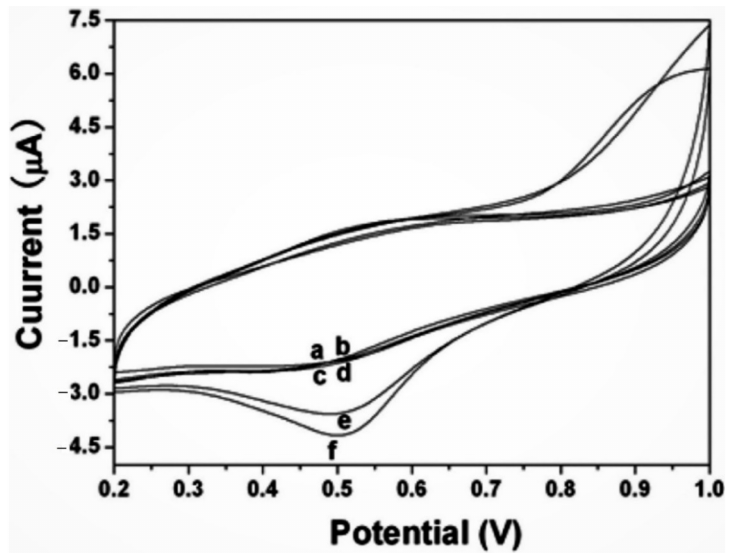
Figure 9. CV curves of GCE ( a , b ), carbon dots/GCE ( c , d ) and carbob dots@Au/GCE ( e , f ) in the absence ( a , c , e ) and presence ( b , d , f ) of 0.2 mg/L ractopamine in a PBS (pH 7.0) solution. Reprinted (adapted) with permission from [76]. Copyright 2020,